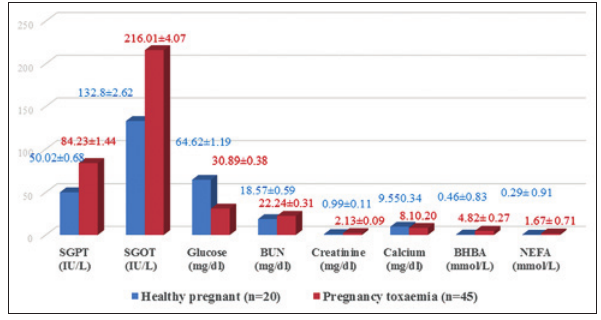
Figure-3: Mean±standard error values of biochemical parameters of healthy pregnant and pregnancy toxemic goats.